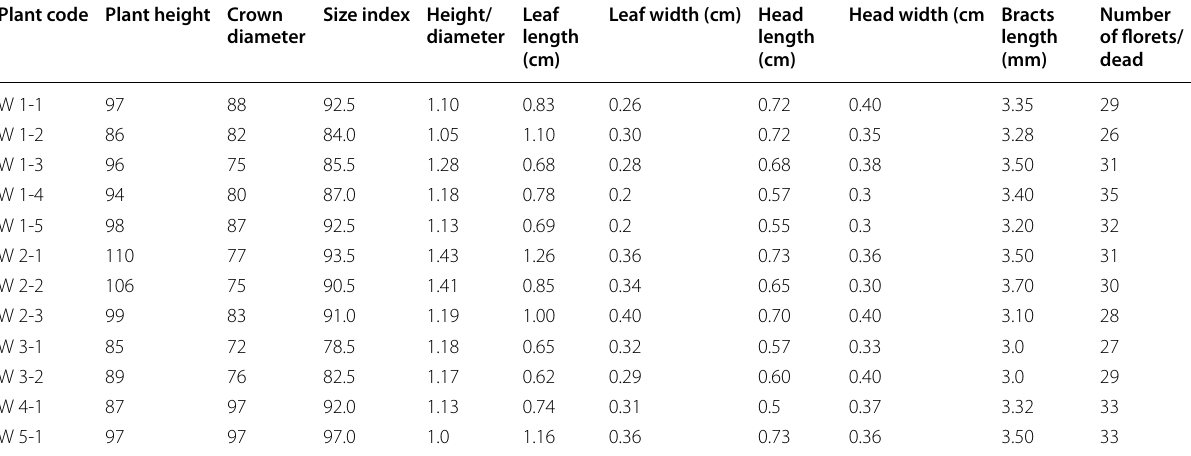
Table 2 Measurements of ten morphological traits for 12 samples of A. fragrantissima Plant code Plant height Crown Size index Height/ Leaf diameter diameter